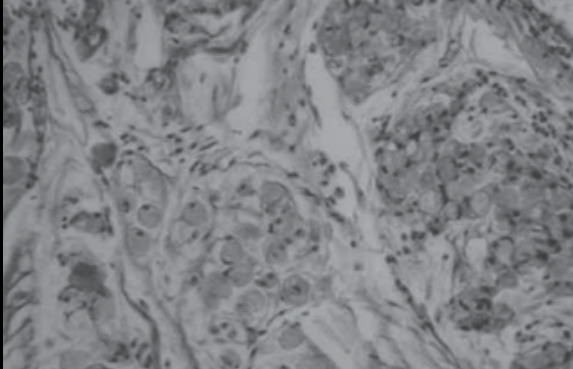
Figura 2 – Expressão citoplasmática de MUC6 no epitélio metaplásico de Barrett e na porção profunda do epitélio colunar em biópsia após FN (250×) FN: fundoplicatura de